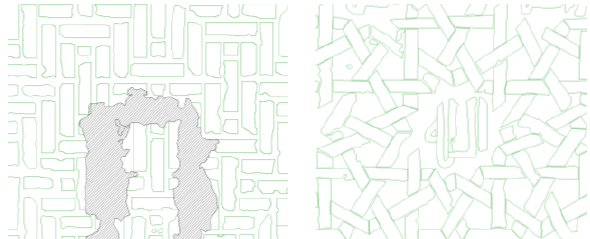
Figure 12. Different Samples of external brick decoration of the tower, CAD drawings